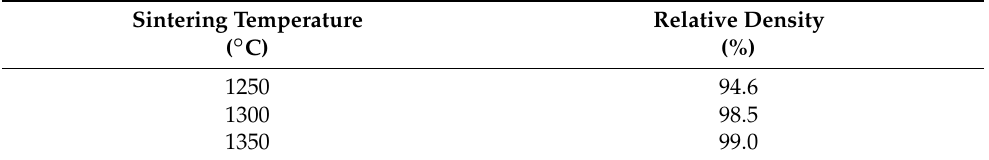
Table 3. Relative density of 17-4PH/zirconia micro-sized components sintered at different tempera- tures for 3 h.